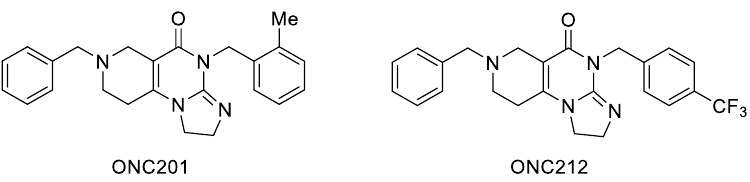
Figure 1. Representative impiridones as reference compounds.